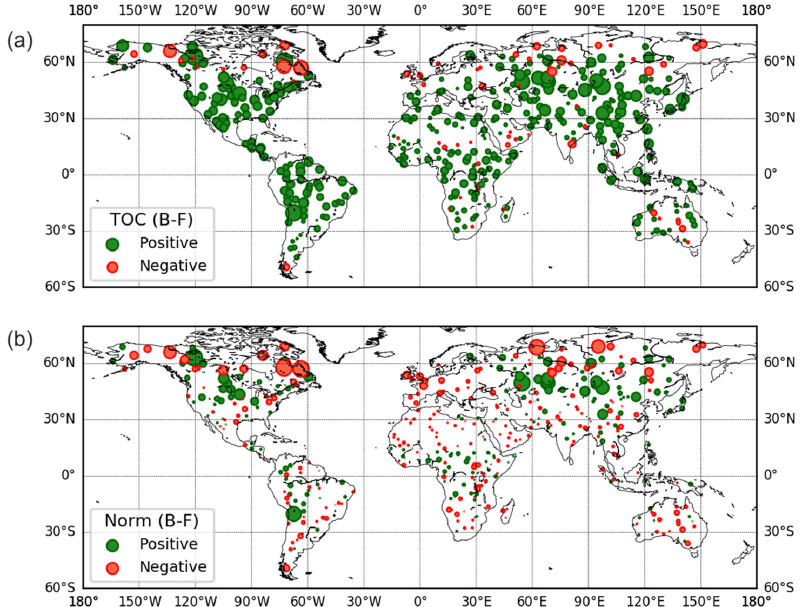
Figure 11. The two maps show the geographical distribution of the differences in the estimated drift ( 𝑑𝑟𝑖𝑓𝑡 (cid:3031)(cid:3036)(cid:3033)(cid:3033) = 𝑑𝑟𝑖𝑓𝑡 (cid:3029)(cid:3028)(cid:3030)(cid:3038)(cid:3050)(cid:3028)(cid:3045)(cid:3031) − 𝑑𝑟𝑖𝑓𝑡 (cid:3033)(cid:3042)(cid:3045)(cid:3050)(cid:3028)(cid:3045)(cid:3031) ) of NIR reflectances over BELMANIP-2 sites for the two temporal series of ( a ) TOC data and ( b ) BRDF-normalized data. The size of the points is proportional to the magnitude of the differences; the color indicates the sign, i.e., green is positive, red is